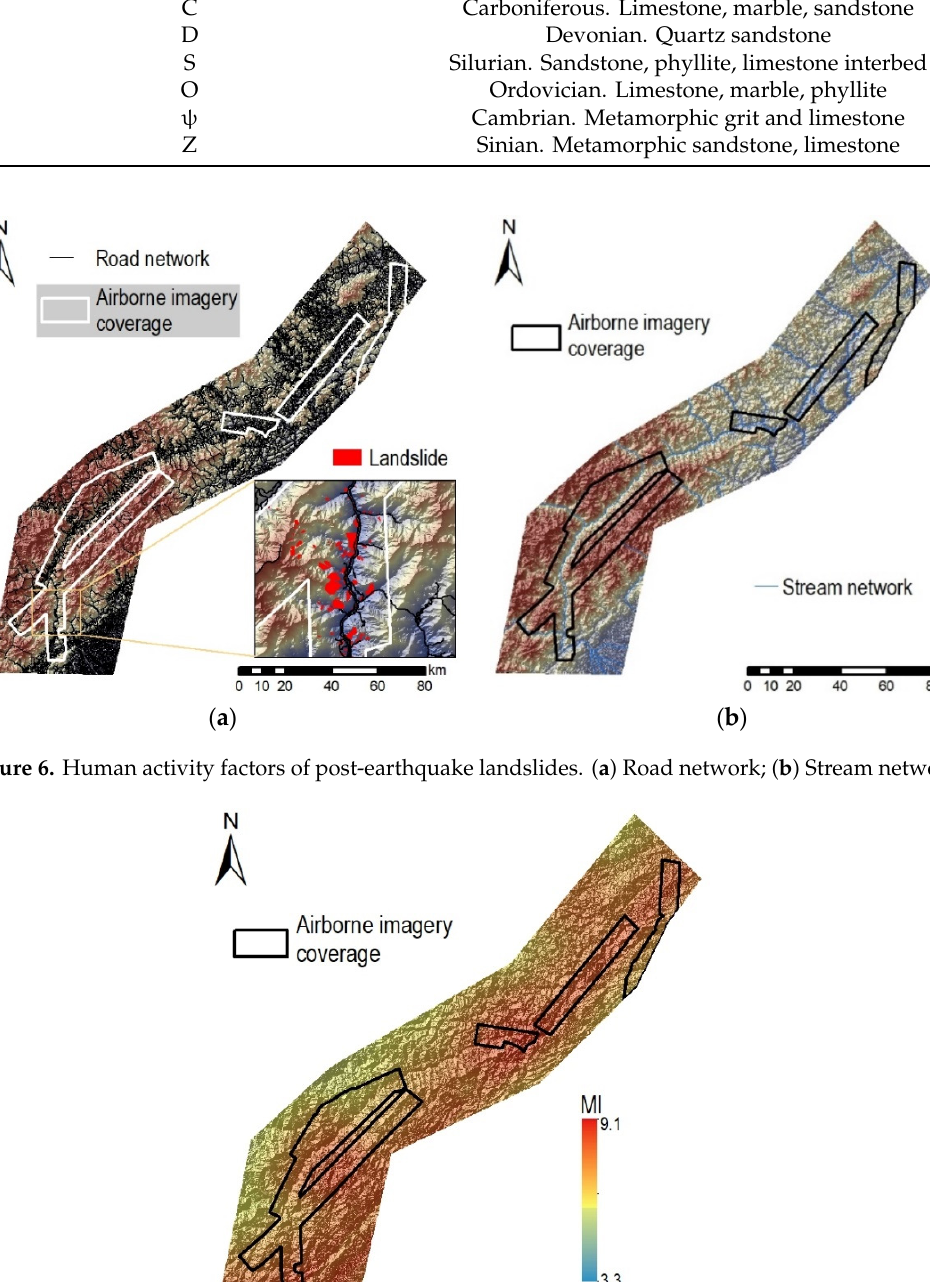
Figure 7. Earthquake macroseismic intensity (MI) distribution of study area. 2.5. U ‐ Net Like Model for Post ‐ Earthquake LSM 2.5.1. Traditional CNN and U ‐ Net Model Traditional CNN models consist of one or more convolution, pooling, or fully connected operation layers. The convolution operation is to extract different features from the input layer. The pooling operation is to reduce the dimensionality of feature maps and make the model more concern about the existence of certain features rather than precise location of the features. The fully connected